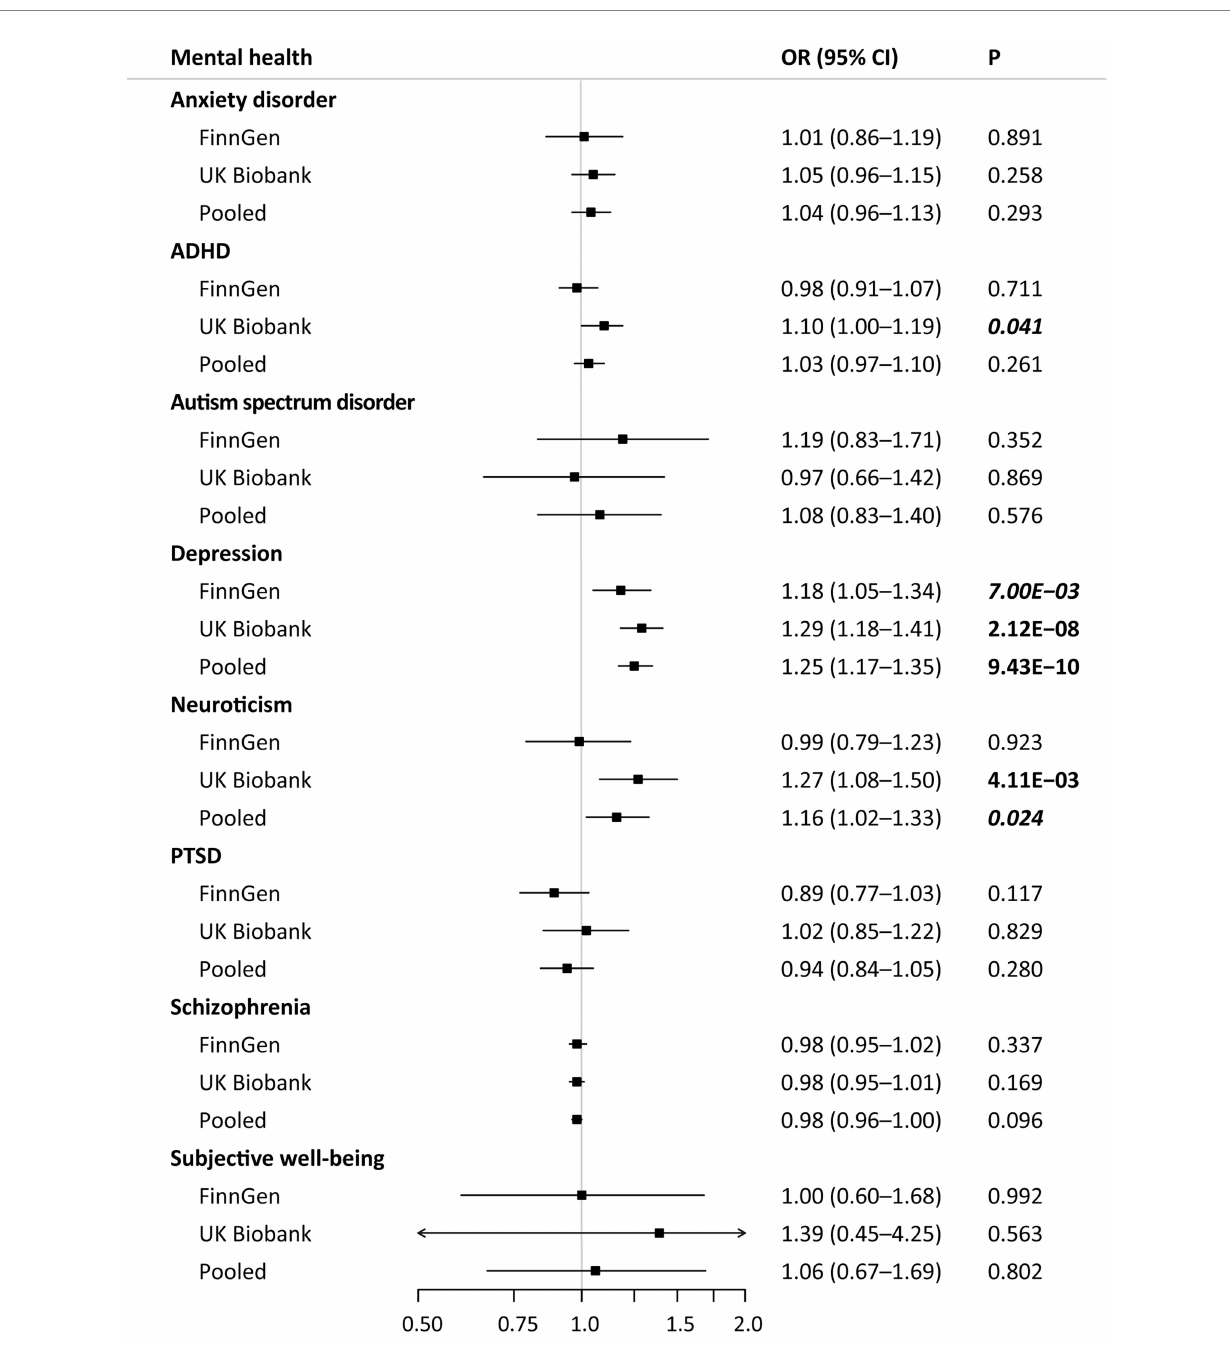
FIGURE 3 Mendelian randomization associations of mental health with hypertension in different data sources. Results are derived from the fixed-effects inverse- variance weighted analysis. ADHA indicates attention deficit/hyperactivity disorder; CI, confidence interval; OR, odds ratio; and PTSD, post-traumatic stress